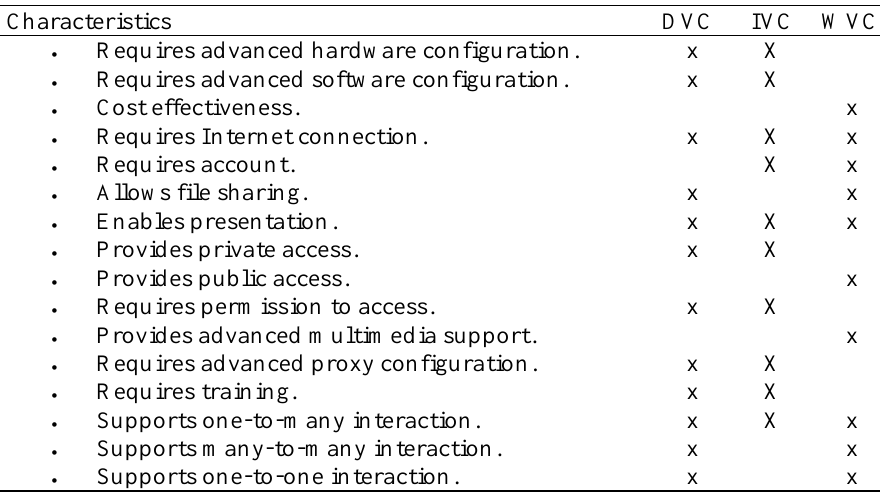
Comparison Between DVC, IVC, and WVC Systems